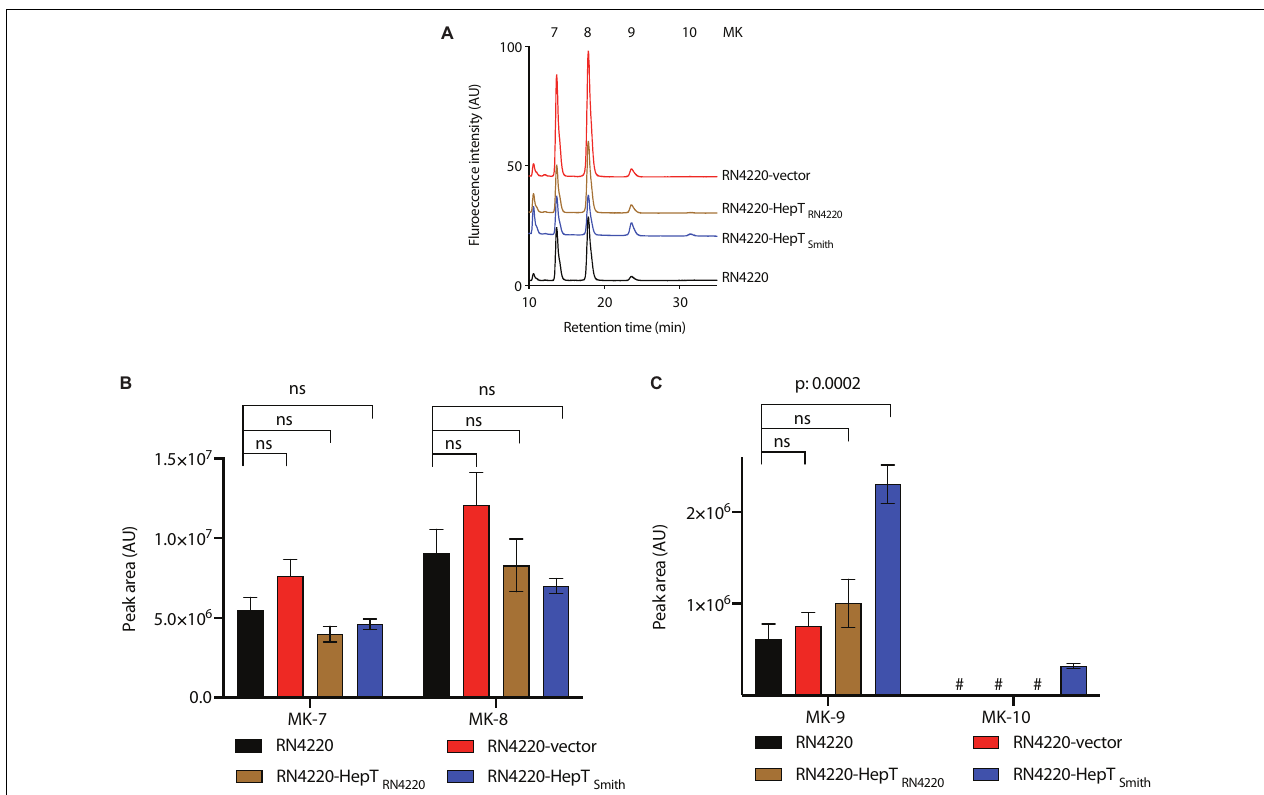
FIGURE 5 | Analysis of MKs from S. aureus RN4220 with heterologously expressed HepT. (A) Representative HPLC chromatograms. (B) Peak area of MK-7 and MK-8. (C) Peak area of MK-9 and MK-10. Data are from three independent experiments and represented as mean ± SEM. Statistical analysis was performed by one-way ANOVA using Dunnett’s multiple comparison test in GraphPad Prism, and a p < 0.05 was considered significant. ns: non-significant. # Indicates an undetectable amount of MK-10.